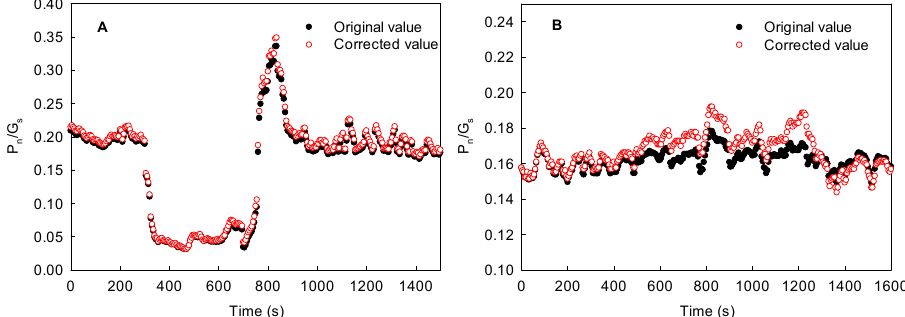
Figure 10. Effects of a changing light environment on the WUE (P n /G s ) of local ( A ) and adjacent regions ( B ) in the same maize leaves in the field. Data from Figure 8. WUE, water use efficiency; corrected value, (P n–F or P n–S + Δ P n )/G s ; P n–F , photosynthetic induction under fluctuating light; P n–S , photosynthesis under steady light intensity; Δ P n , the changes in P n–S of adjacent region during the transition of the local regions from dark or low-light regions to high-light regions in the same leaves.